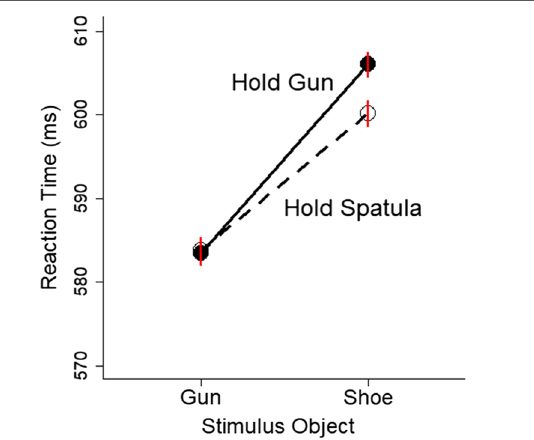
Fig. 7 Mean reaction time is plotted as a function of the stimulus object (gun and shoe) and the hold condition (gun and spatula). Error bars are 1 SEM calculated within-subjects. The gun embodiment effect is shown by the steeper solid line compared with the dashed line. This shows slower reaction time to respond that a shoe is present versus gun is present when holding a gun compared with when holding a